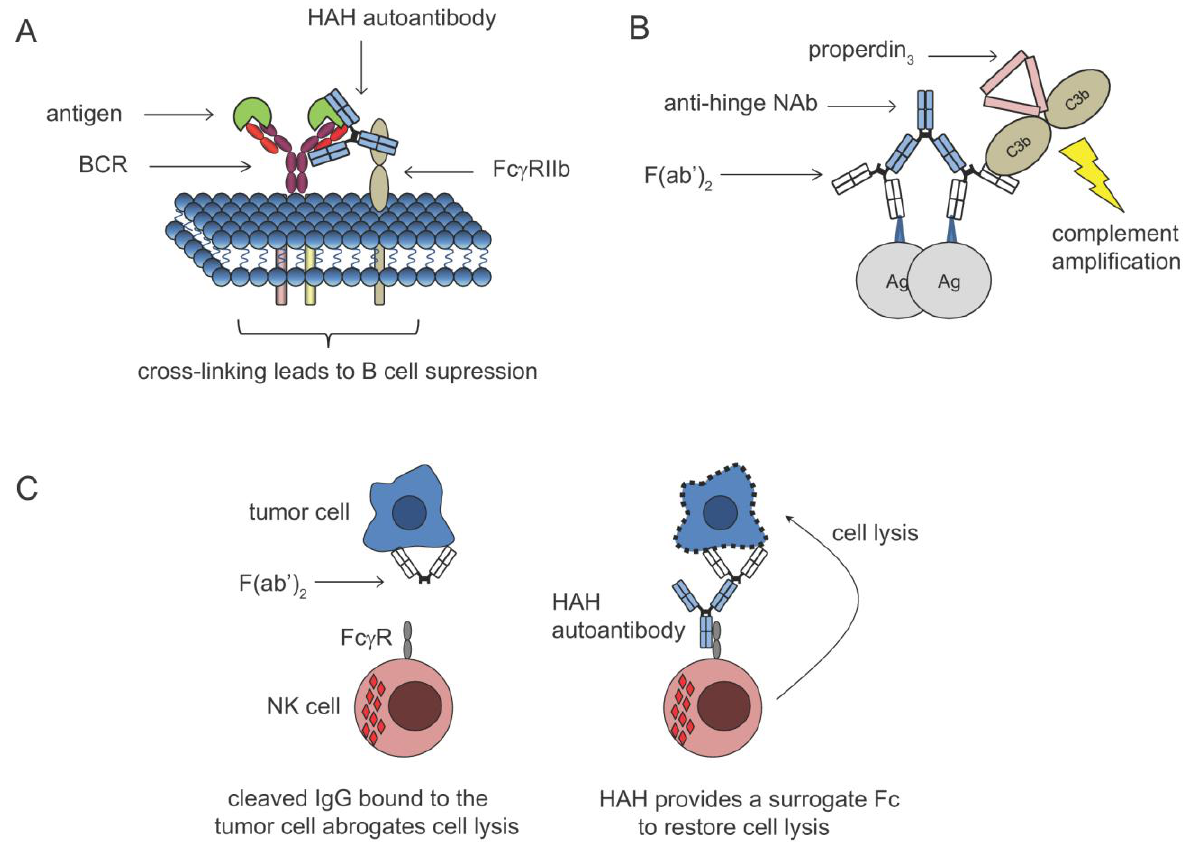
FIGURE 2. Proposed functional mechanisms for HAH autoantibodies. (A) The Fc region of autoantibodies that bind to antigen-engaged BCR coligate FcγRIIb, which leads to B-cell suppression (reviewed in Terness et al.[5]). (B) Antihinge NAbs that bind to immune-complexed F(ab’) resulting in docking of C3b and complement amplification[13]. (C) HAH autoantibodies bind to F(ab’) on target cells and provide a surrogate Fc domain that can interact with effector immune cells, resulting in target cell